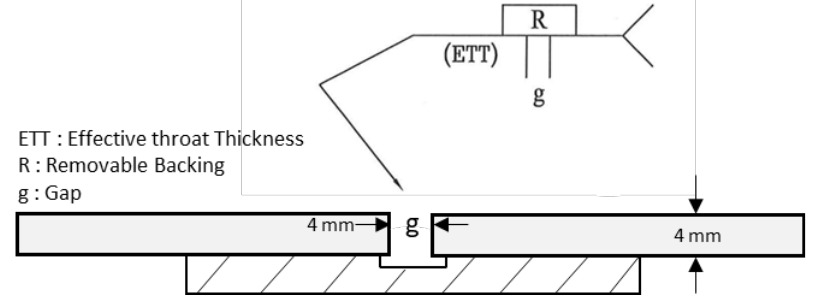
Figure 4. GMAW-P welding drawing.